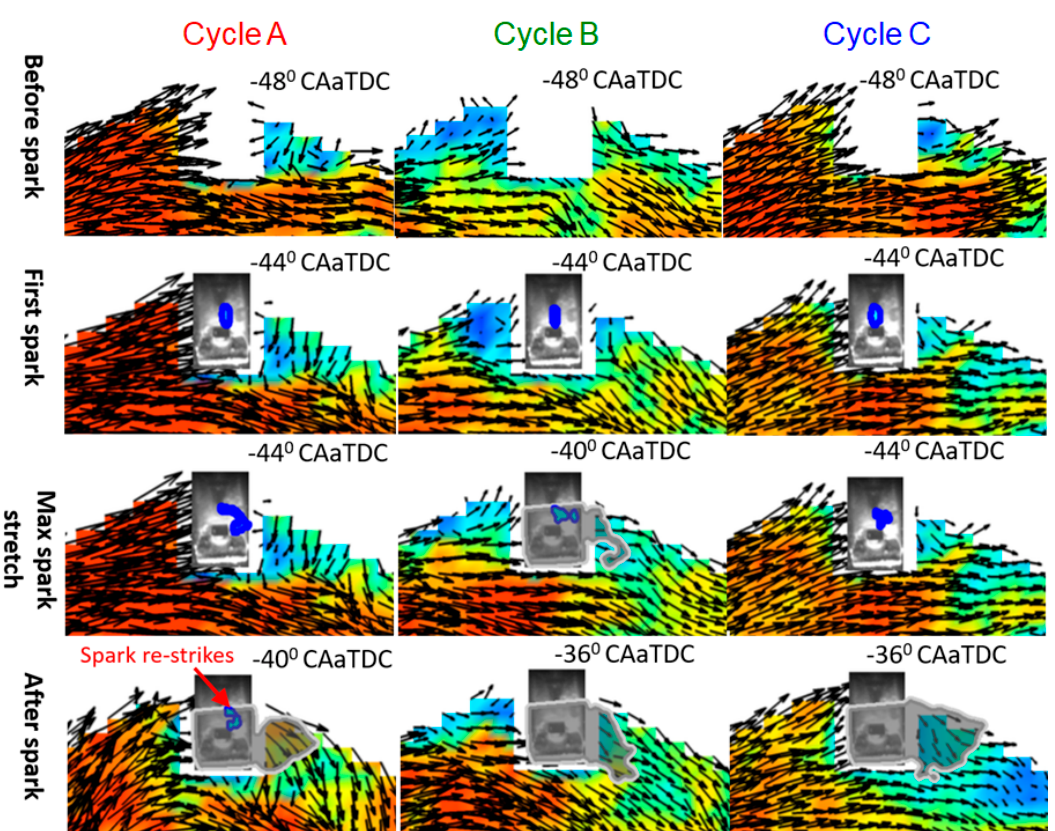
Figure 7. Near spark combined PIV-flame-spark images of three selected cycles (A, B, and C) at 1700 rpm condition.